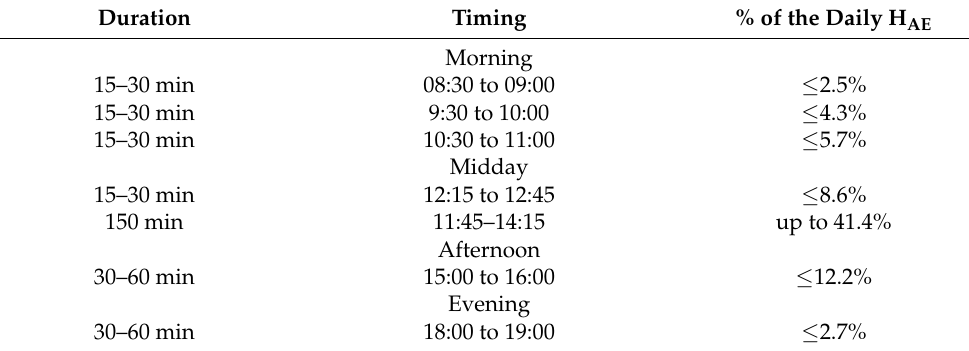
Table 1. Contribution of exposure at the different times of day to the daily ambient available H AE for different exposure scenarios in April–June.